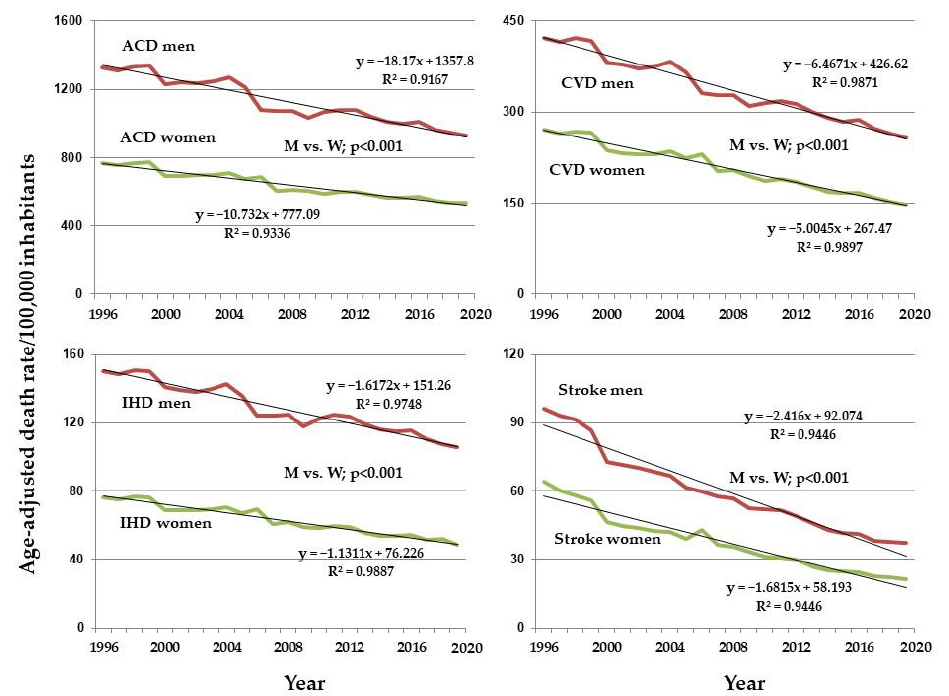
Figure 2. Comparisons of adjusted death rates regression lines per 100,000 population and regression data for all causes of death (ACD), cardiovascular disease (CVD), ischemic heart disease (IHD), and stroke in women and men from 1996 to 2019.